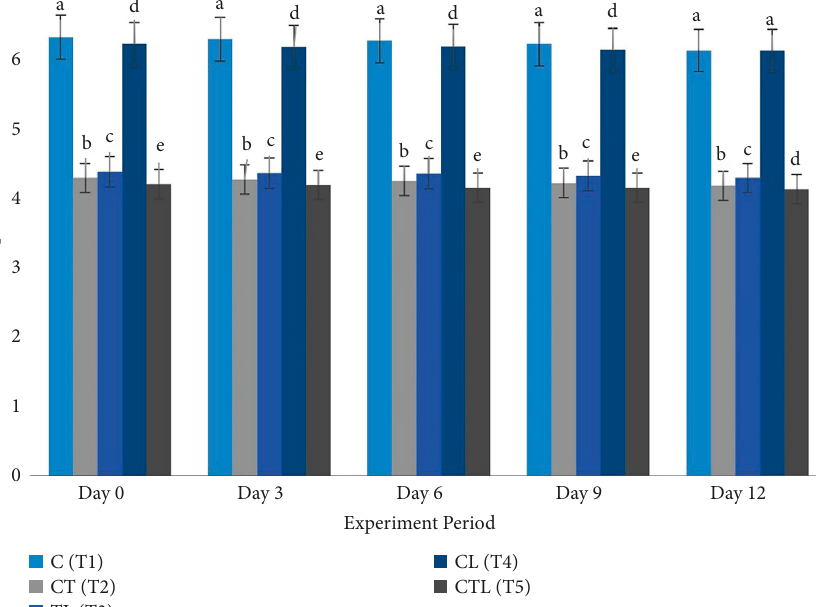
Figure 5: pH content in the carp fillet immersed in mixed different extracts of turmeric, cinnamon, and lemon at 4 °